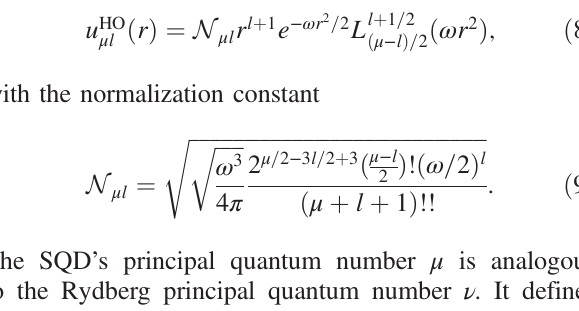
FIG. 2. Density of states dN=d (a), 2D (b), and 3D (c) as a function of scaled lattice spacing d= ν